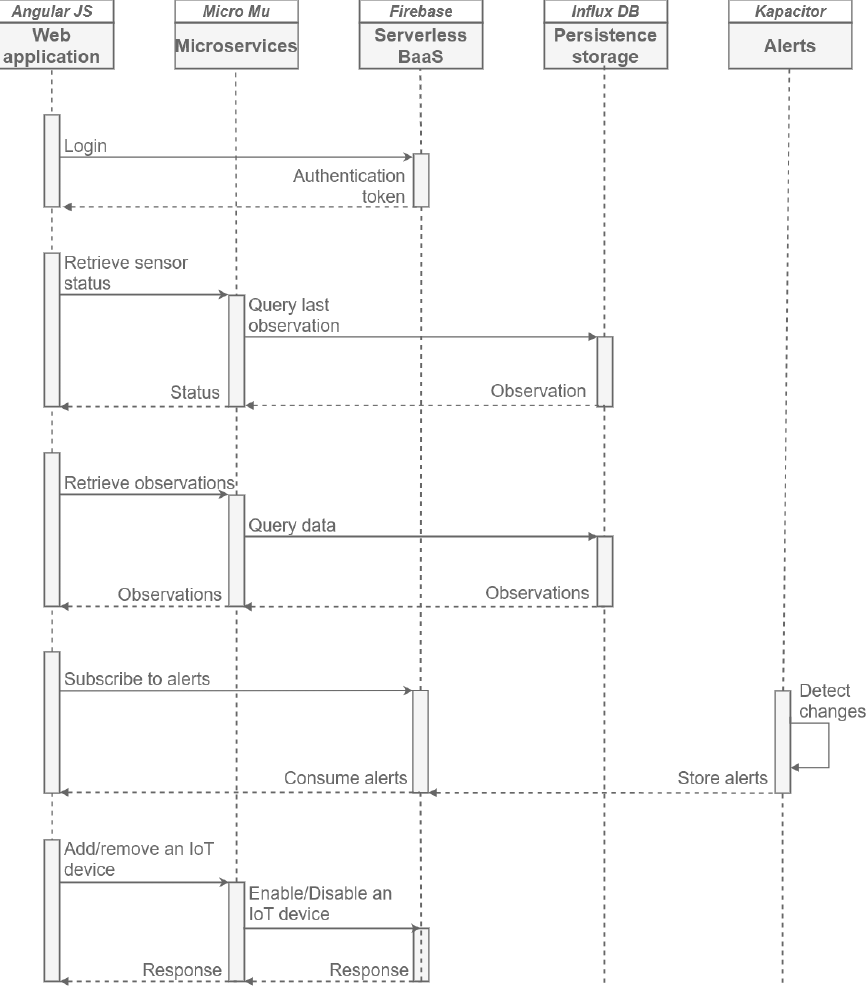
Figure 7. A sequence diagram from the user